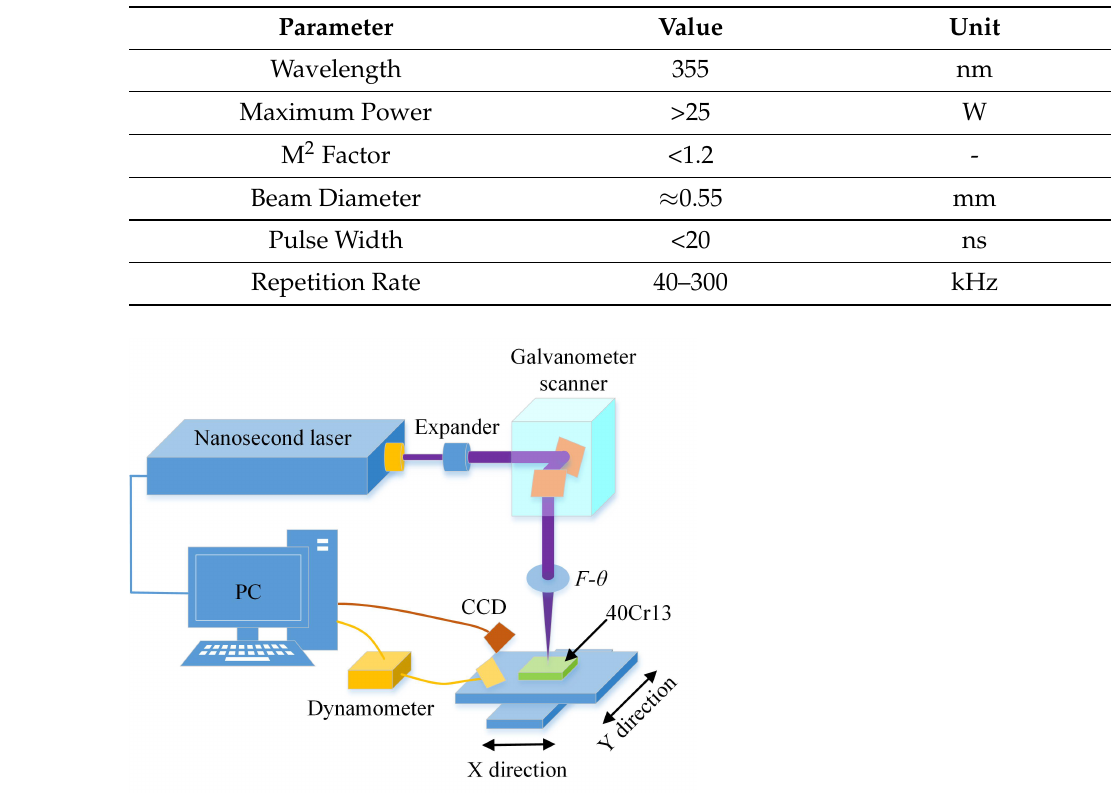
Table 2. Main parameters of nanosecond pulse laser.